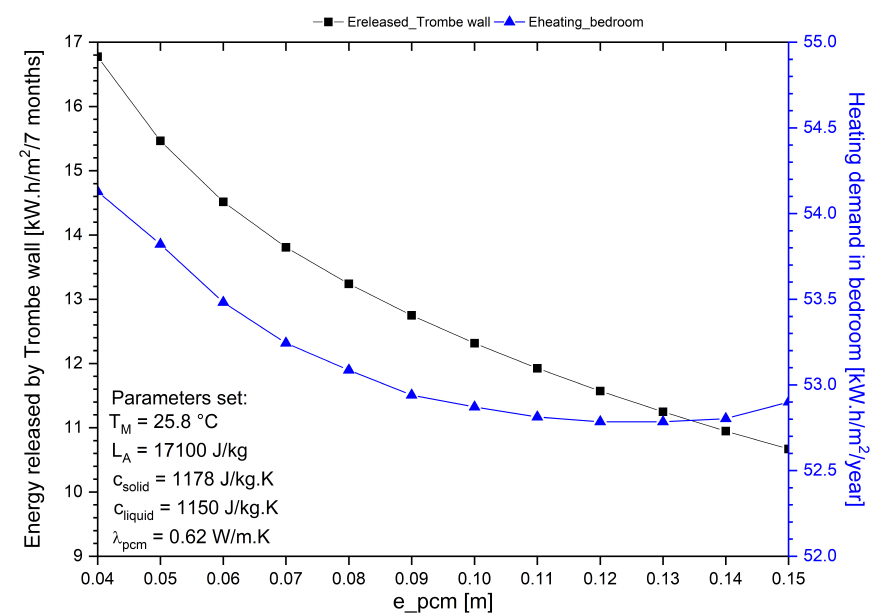
Figure 8. Energy released by the solar Trombe wall and heating demand vs. storage wall thickness during the cold season (7 months total: January–April and October–December).